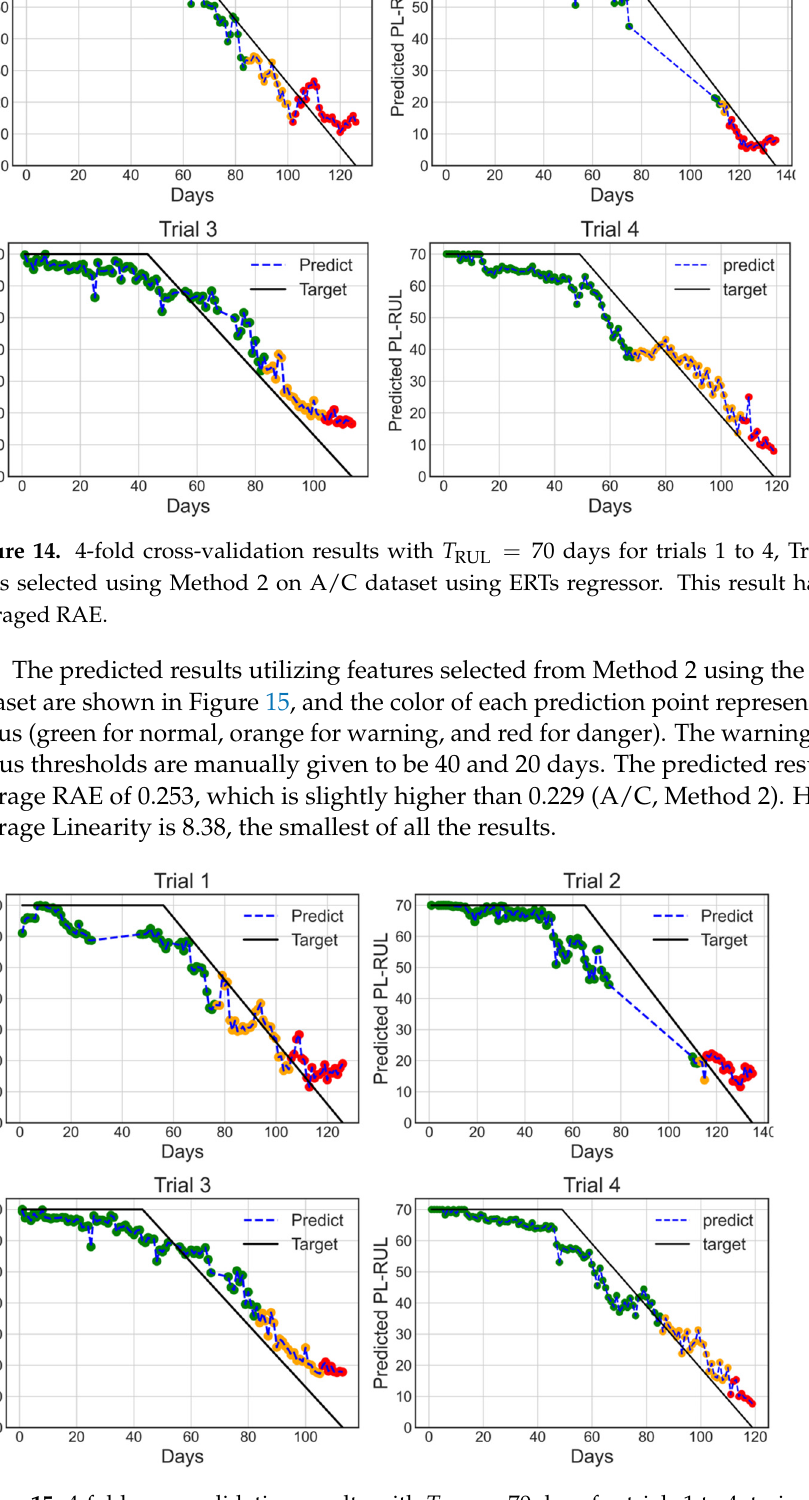
Figure 15. 4-fold cross-validation results with T RUL = 70 days for trials 1 to 4, trained on features selected using Method 2 on acceleration dataset having ERTs regressor with 100 estimators. This condition has the lowest averaged Linearity.